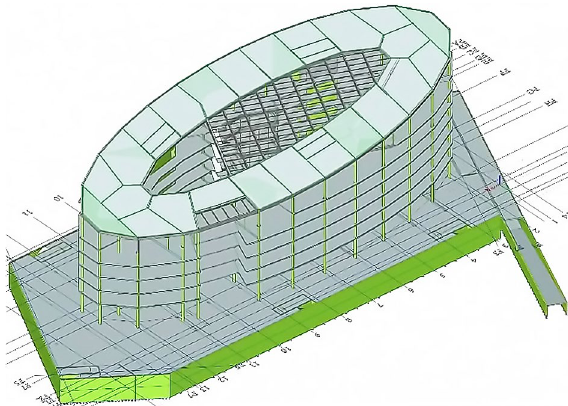
Fig. 8. A global structural scheme of the building